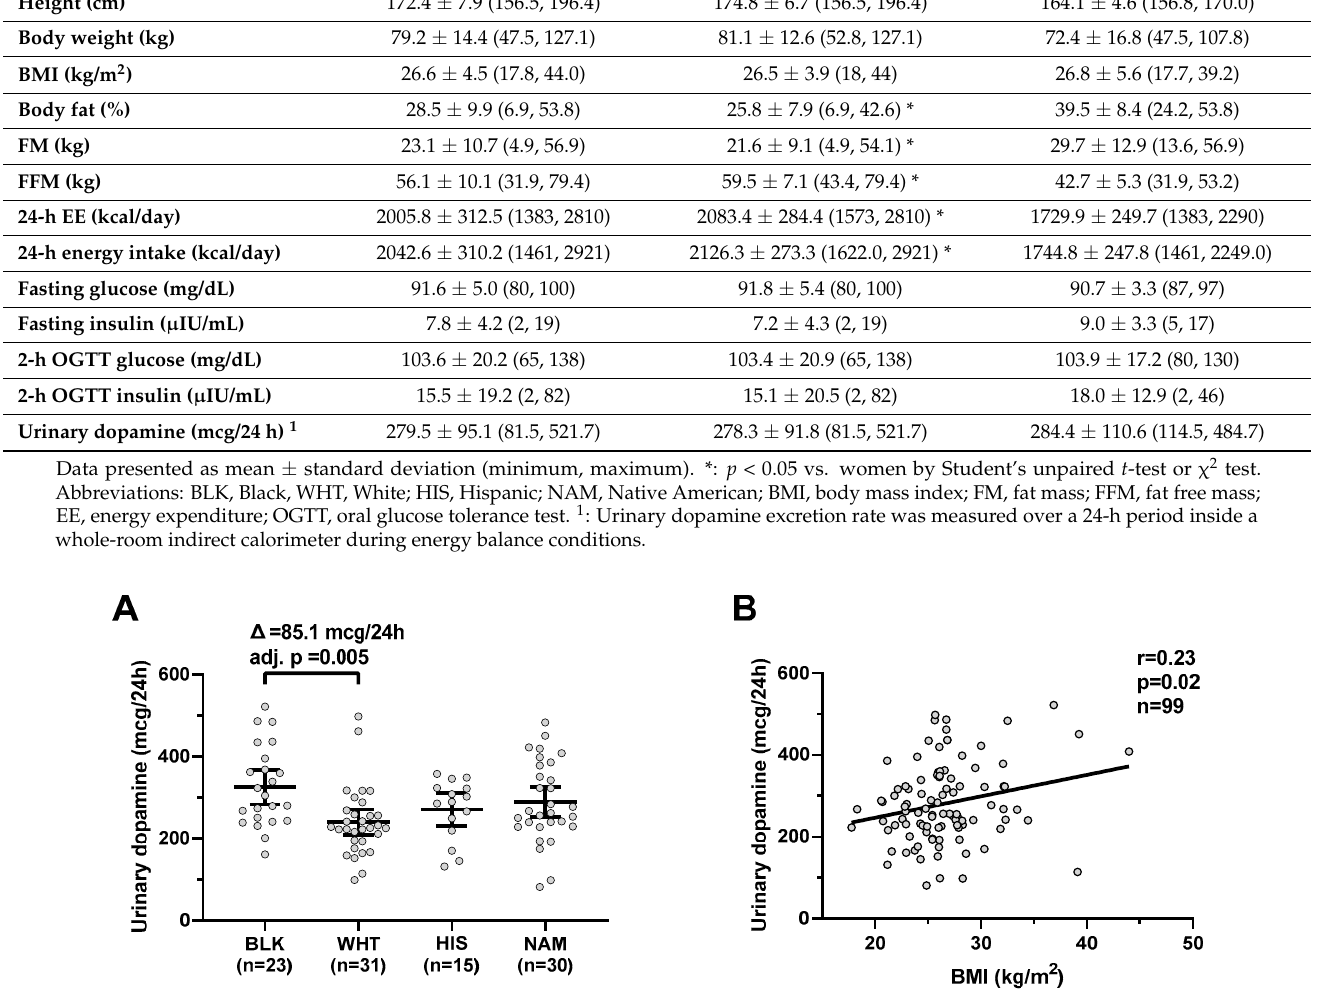
Figure 1. Urinary dopamine during eucaloric conditions by ethnicity and its relationship with BMI. Panel ( A ) shows urinary dopamine excretion rates during 24-h eucaloric conditions across ethnicities. The average difference ( ∆ ) in urinary dopamine concentrations between Blacks and Whites was calculated and tested via ANOVA with Tukey adjustment of the least square means for multiple comparisons. Error bars represent mean with 95% CI. Panel ( B ) shows the positive association between BMI and 24-h urinary dopamine excretion rate during 24-h eucaloric conditions. The Pearson’s correlation coefficient (r) is reported along with its significance ( p ). Abbreviations: BLK, Black, WHT, white; HIS, Hispanic; NAM, Native American.